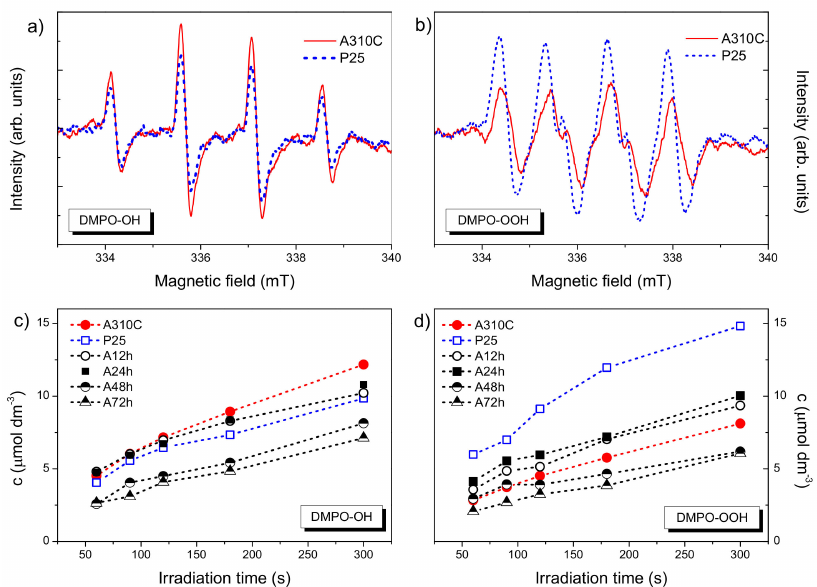
Figure 8. Results of the electron paramagnetic resonance (EPR) spectroscopy investigation. ( a , b ) EPR spectra of DMPO-OH and DMPO-OOH adducts recorded after UV light irradiation for 300 s using A310C and Degussa P25 photocatalysts; ( c , d ) formation of DMPO-OH and DMPO-OOH adducts in di ff erent TiO 2 dispersions as a function of UV irradiation time. The dispersions contained 0.1 mg / mL of TiO 2